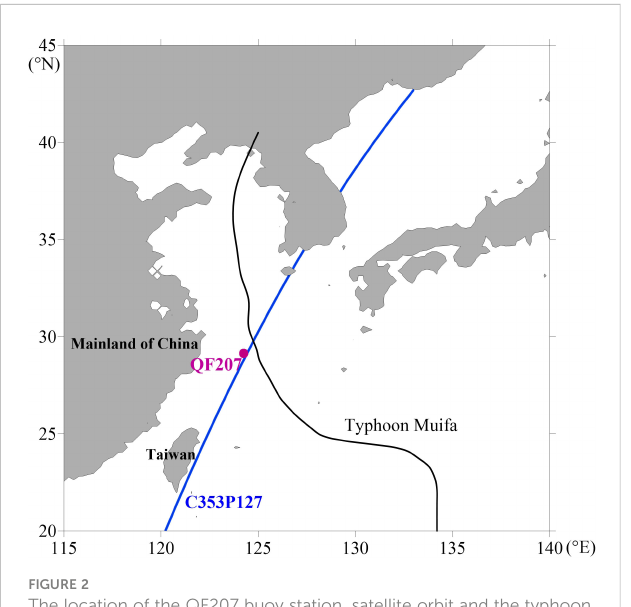
FIGURE 2 The location of the QF207 buoy station, satellite orbit and the typhoon path.